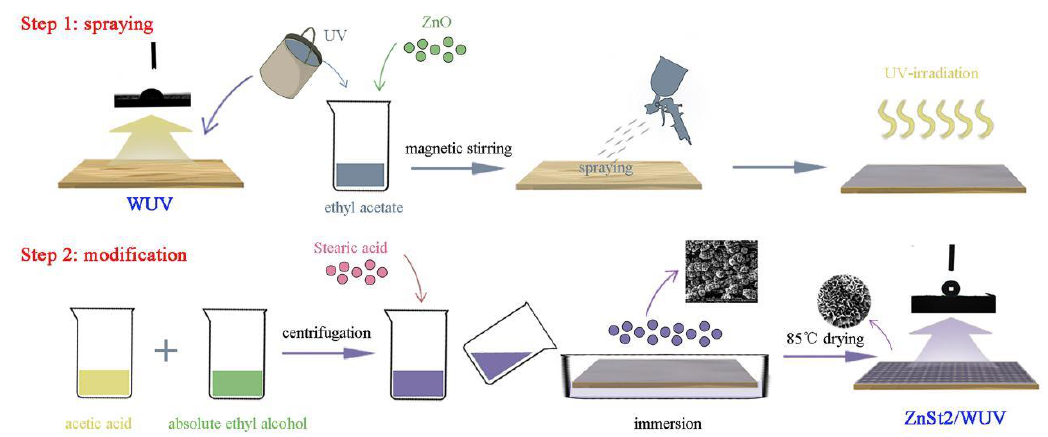
Figure 1. Diagram of modification process.